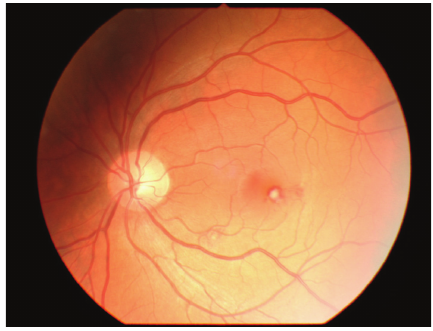
Figure 2: Color fundus photograph of the left eye presenting Roth spots in the macula and the inferior temporal branches region.